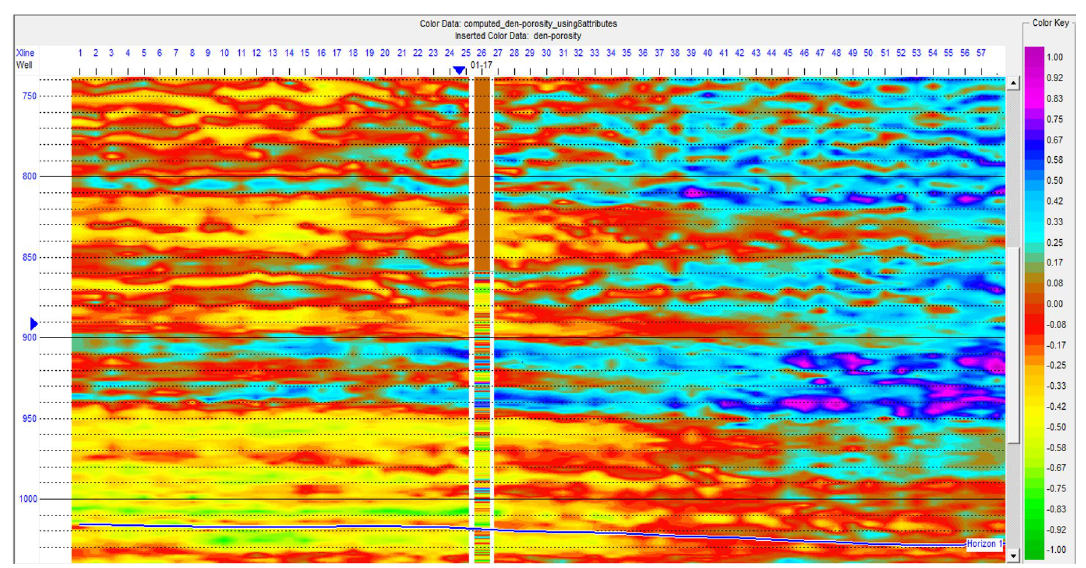
Fig. 16 Porosity obtained by applying multi-attribute regression on the second category data at one section and the desired well parameters